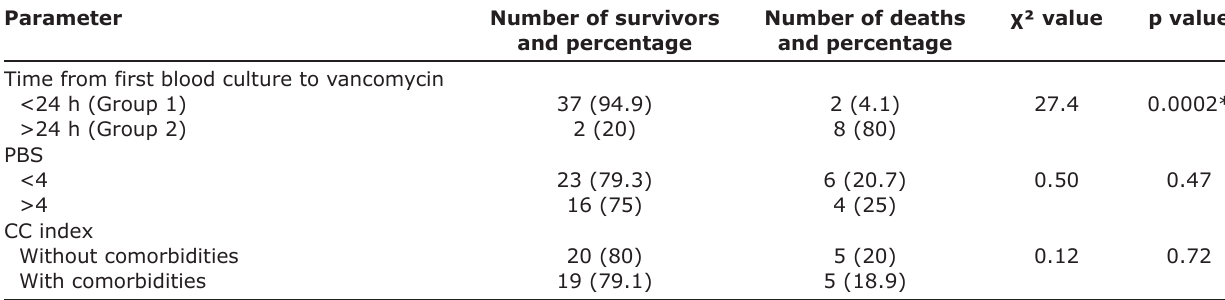
Table-2: Effect of timely initiation of vancomycin therapy, CC index, and PITTS score on 7 th day mortality and survival rates of patients with MRSA bacteremia.